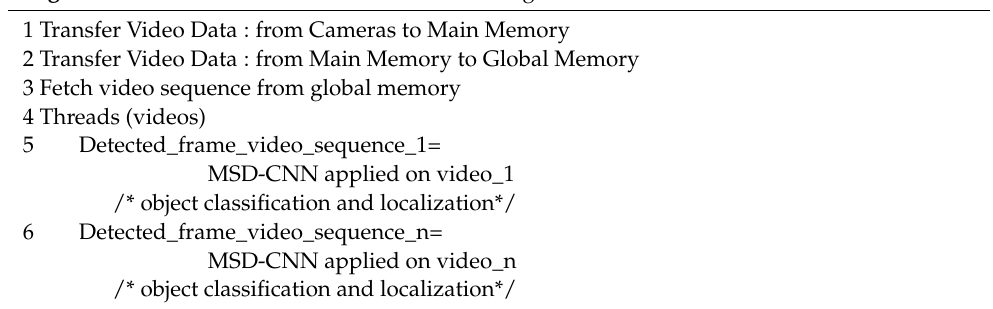
Algorithm 1. Detection in multiview cameras using